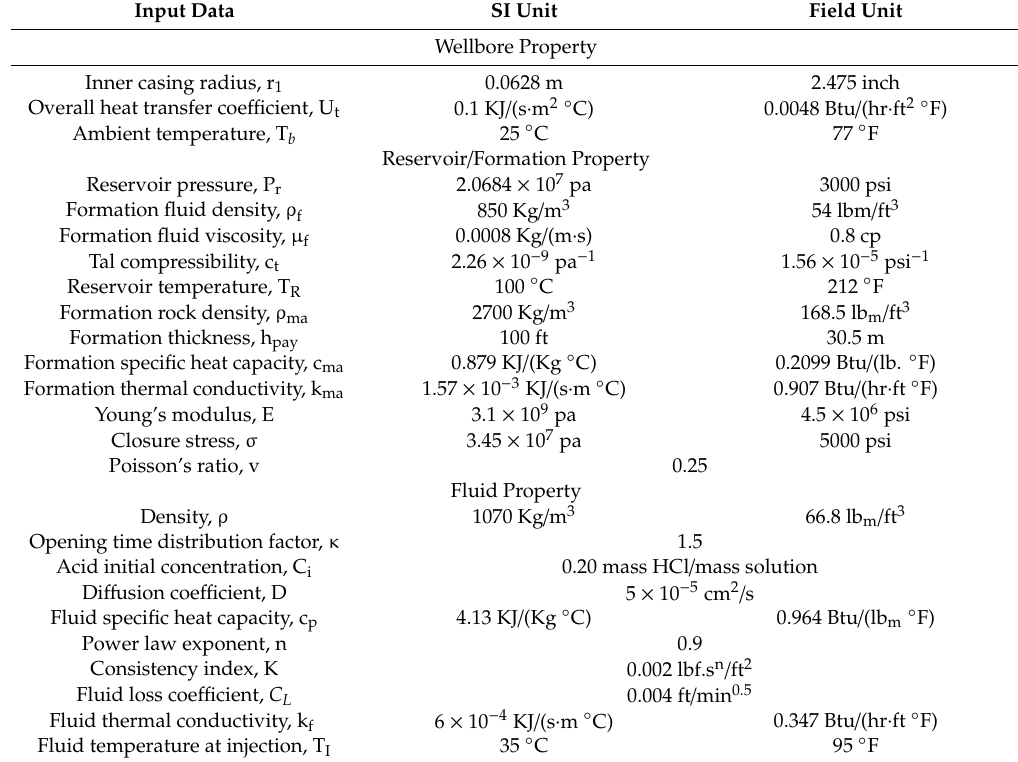
Table 1. Input data for the simulations [27,28].